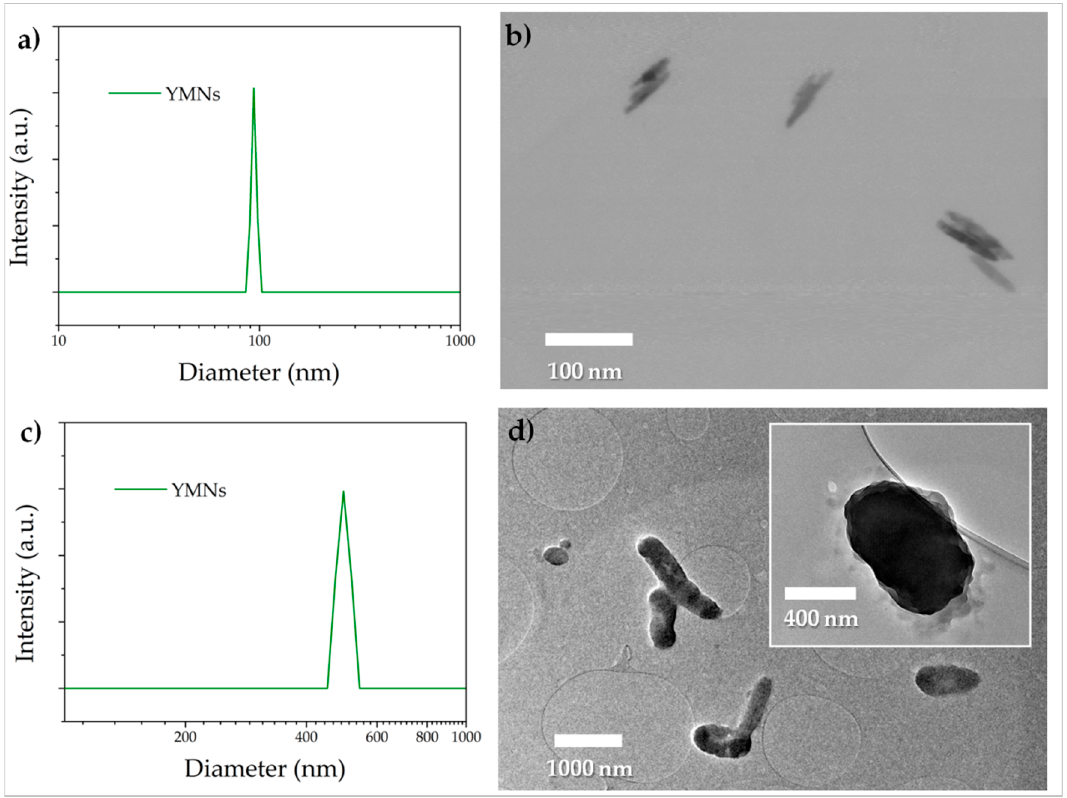
Figure 3. YMNs solution: ( a ) DLS measurements and ( b ) TEM images. YMNs powder: ( c ) DLS measurements and ( d ) TEM images.